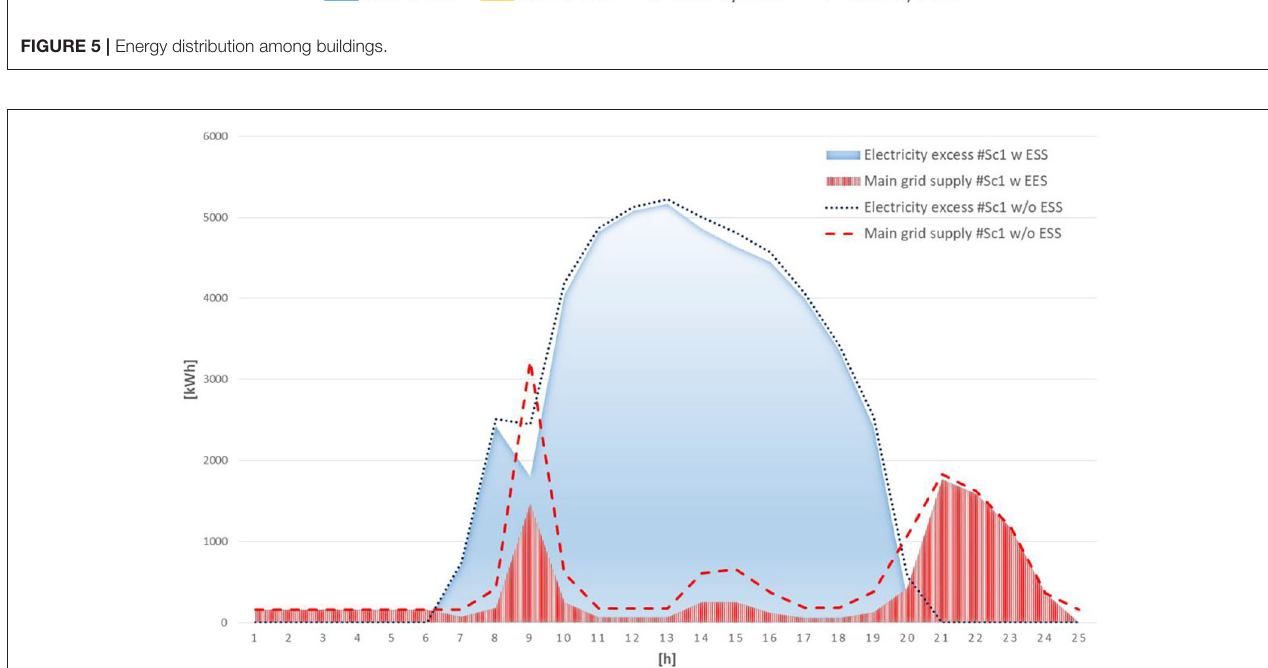
FIGURE 6 | Hourly electricity balance and main grid supply for